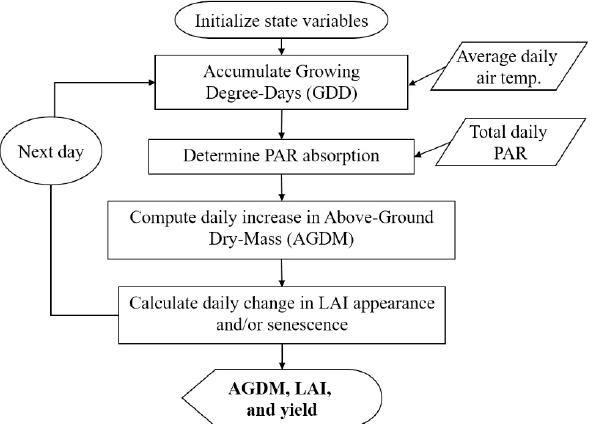
Figure 2. Schematic diagram of a daily simulation process of crop growth. LAI = leaf area index; PAR = photosynthetic active radiation.